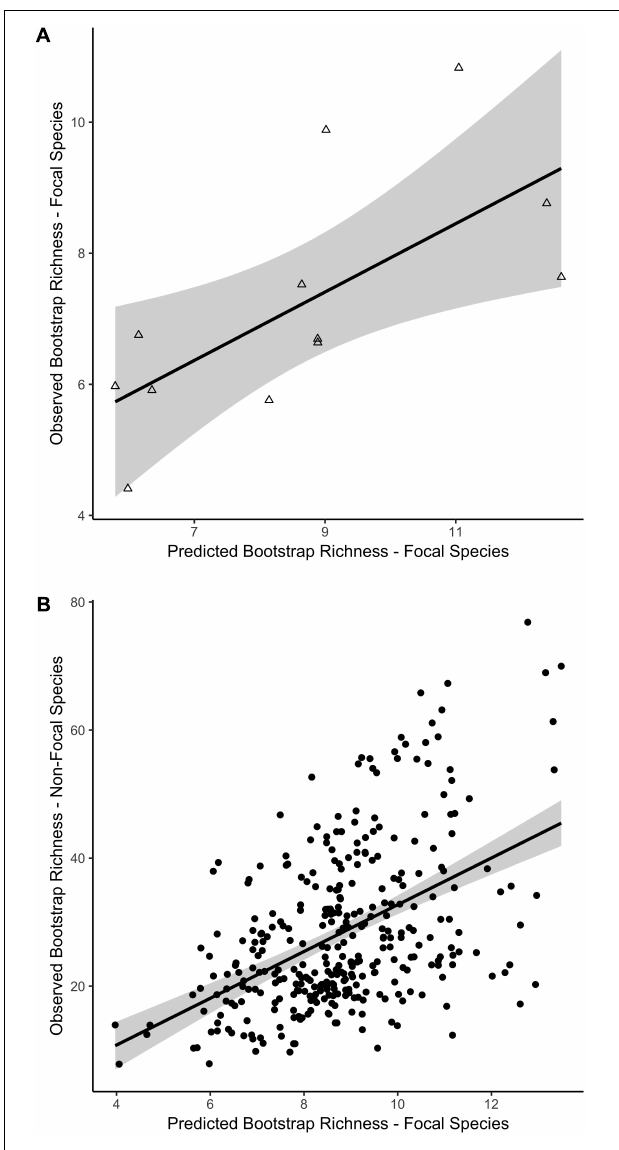
FIGURE 4 | Linear relationship between predicted and observed bootstrap species richness for two independent datasets based on the best fit model for natural reefs. Predicted versus observed species richness for (A) the 21 focal species on established manmade reefs and (B) the 204 non-focal fish, algae, and invertebrate species on all reef sites, including natural and manmade, at four depth zones. Colors indicate mean standard deviation (SD) of relief at each reef site, from low (blue) to high (red) relief. 95% confidence intervals of the regression lines are shown in